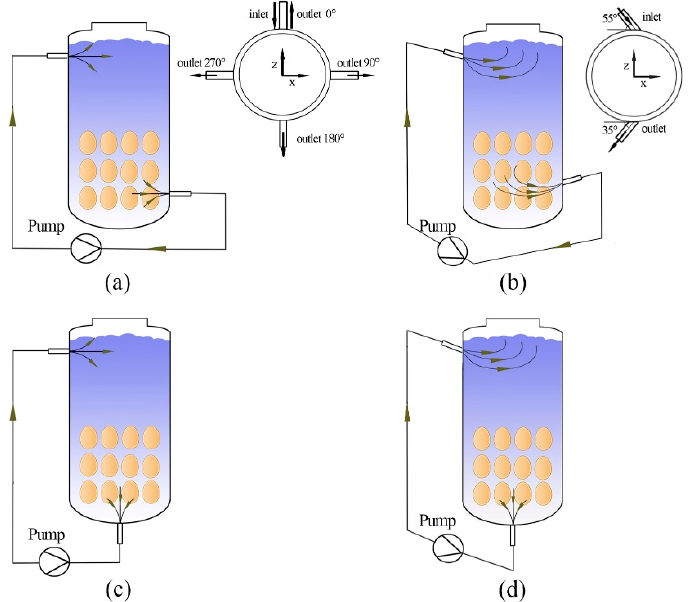
Figure 2. Schematic diagram of the liquid-cycle inlet and outlet settings: ( a ) radial inlet and outlet, ( b ) radial inclination of the inlet and outlet at a certain angle, ( c ) radial inlet and axial outlet, ( d ) radial deflection of the inlet and axial outlet.